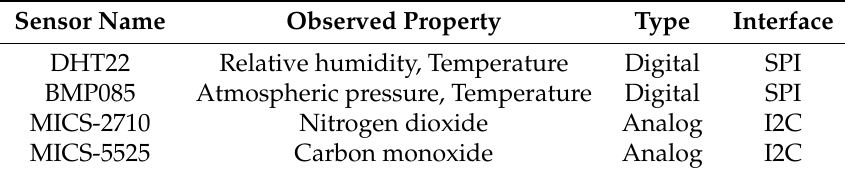
Table 1. AirPi sensors with their respected observed properties.